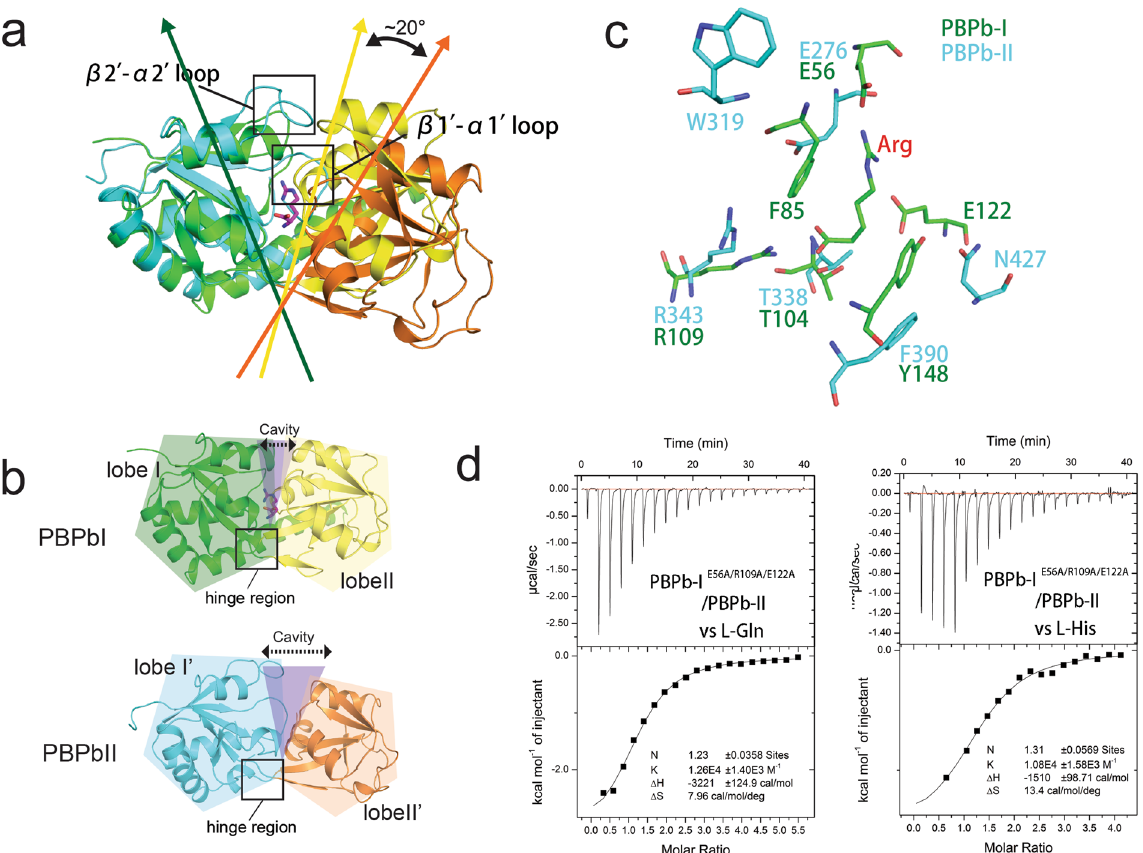
Figure 4. Structural comparison between the PBPb-I and PBPb-II domains. ( a ) Structural superposition of the PBPb-I and PBPb-II domains. The regions affecting the ligand-binding pocket of the PBPb-II domain are shown in the red rectangle. The opening angles for the PBPbs are indicated. Lobe-I and lobe-II of the PBPb-I domain are shown in green and yellow, respectively, while lobe-I ′ and lobe-II ′ of the PBPb-II domain are shown in cyan and orange, respectively. The L-arginine bound in the ligand-binding pocket is shown in magenta. ( b ) Ribbon representation of the closed PBPb-I and open PBPb-II domains. The cavities are shown in light magenta. ( c ) Superposition of the key ligand-binding residues of the PBPb-II domain (cyan) and PBPb-I domains (green). ( d ) Data from ITC experiments involving PBPb-I E56A/R109A/E122A /PBPb-II with L-glutamine and